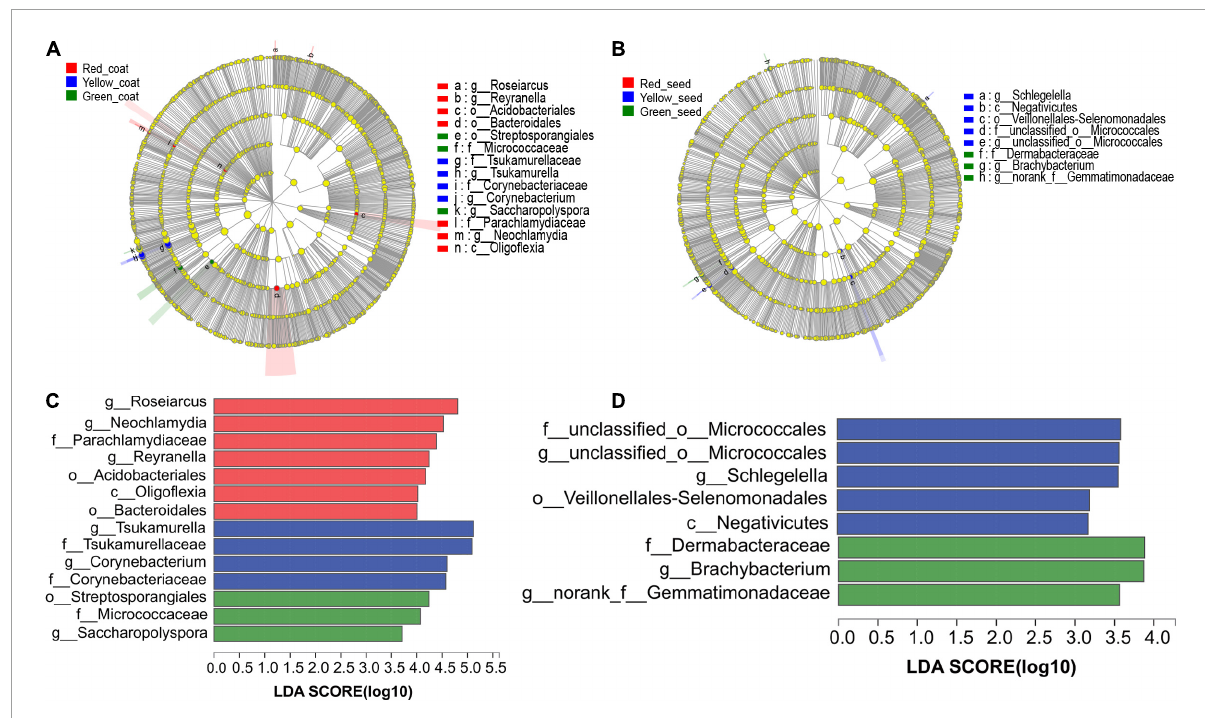
FIGURE5 LEfSe analyses of the aggregated groups of bacterial communities in coats and seeds at different maturity stages (taxa from the phylum to the genus level). Cladogram representing the abundance of the taxa in the coats (A) and seeds (B) . Histogram of the microbiota of coats (C) and seeds (D) with LDA =